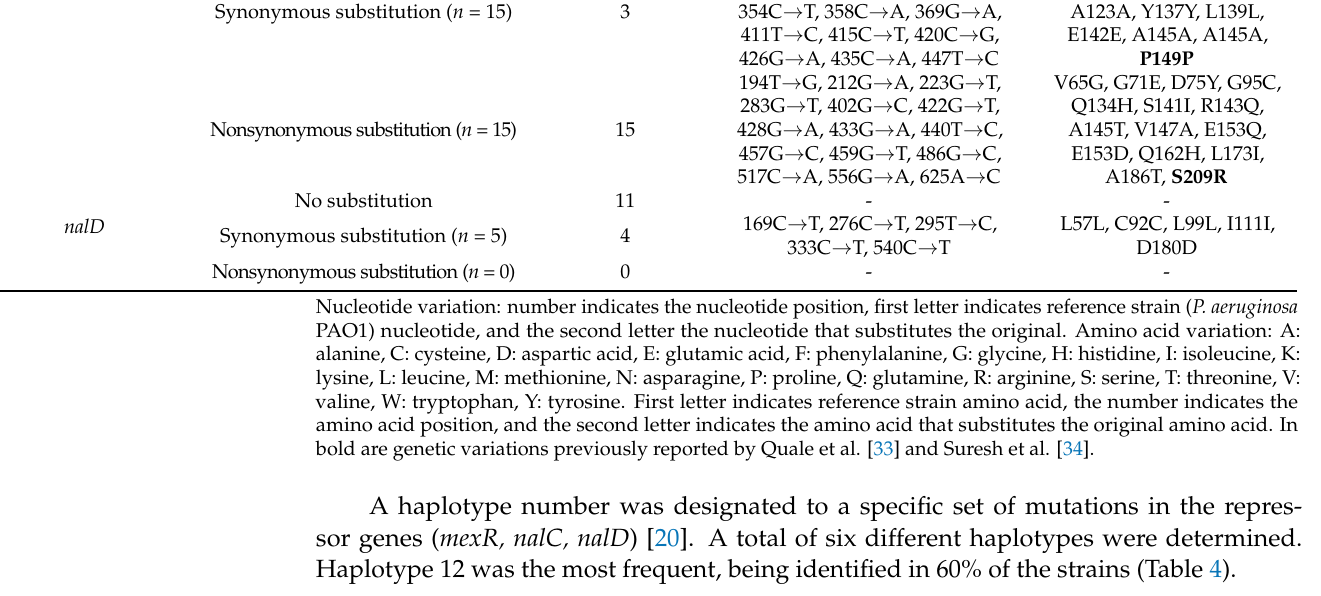
Table 4. Identified haplotypes of the MexAB-OprM efflux pump repressor genes in P. aeruginosa